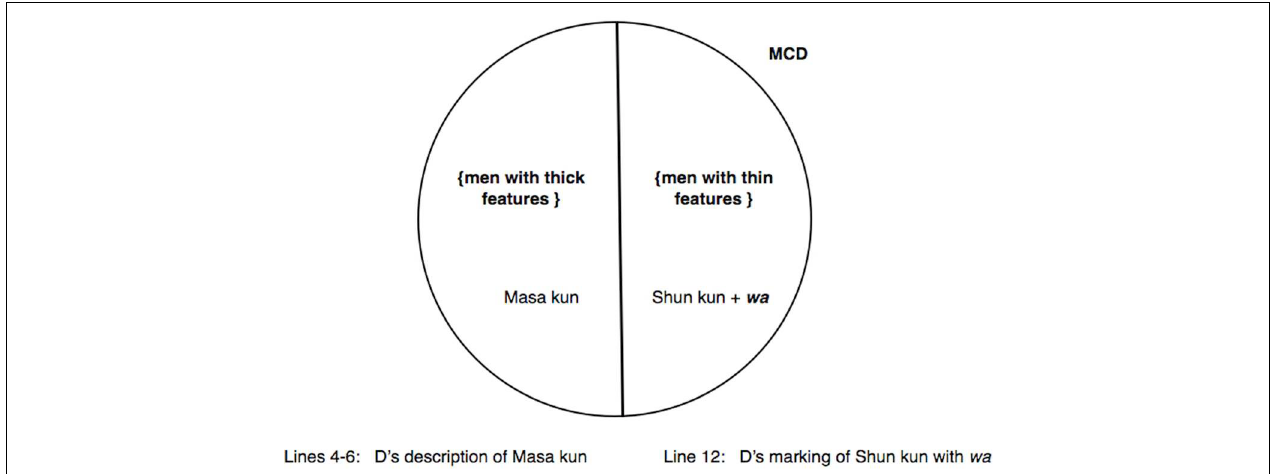
FIGURE 4 | Excerpt (7): The MCD jointly defined by participants by applying a binary opposition partitioning “eligible men” along the parameters “thick” or “thin” features.